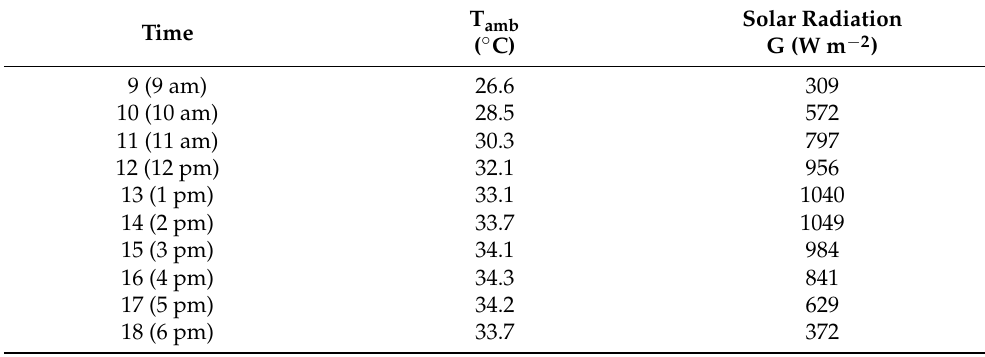
Table 3. Singapore hourly solar insolation on the hottest day (5